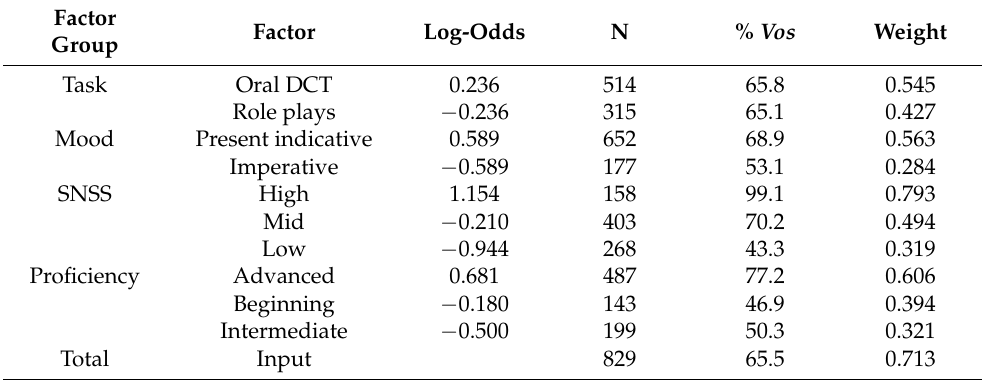
Table 5. Vos Verb Forms Versus T ú Verb Forms (application value = vos verb